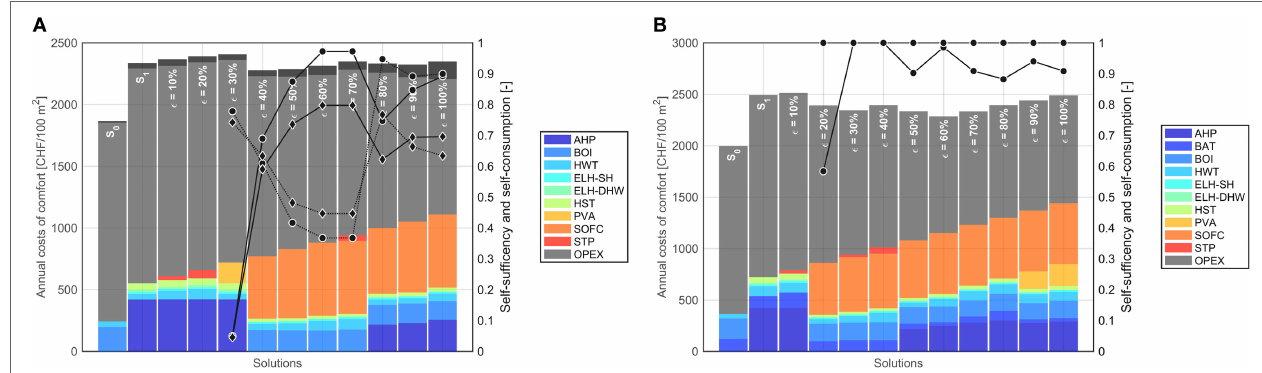
FIGURE 10 | Multi-objective optimization results for an apartment block (Geneva, 1970–1980). Differences in operating costs between both control methods are represented by the dark gray stacked boxes. The self-consumption and self-sufficiency are represented through dotted and solid lines, respectively (MPC circles and